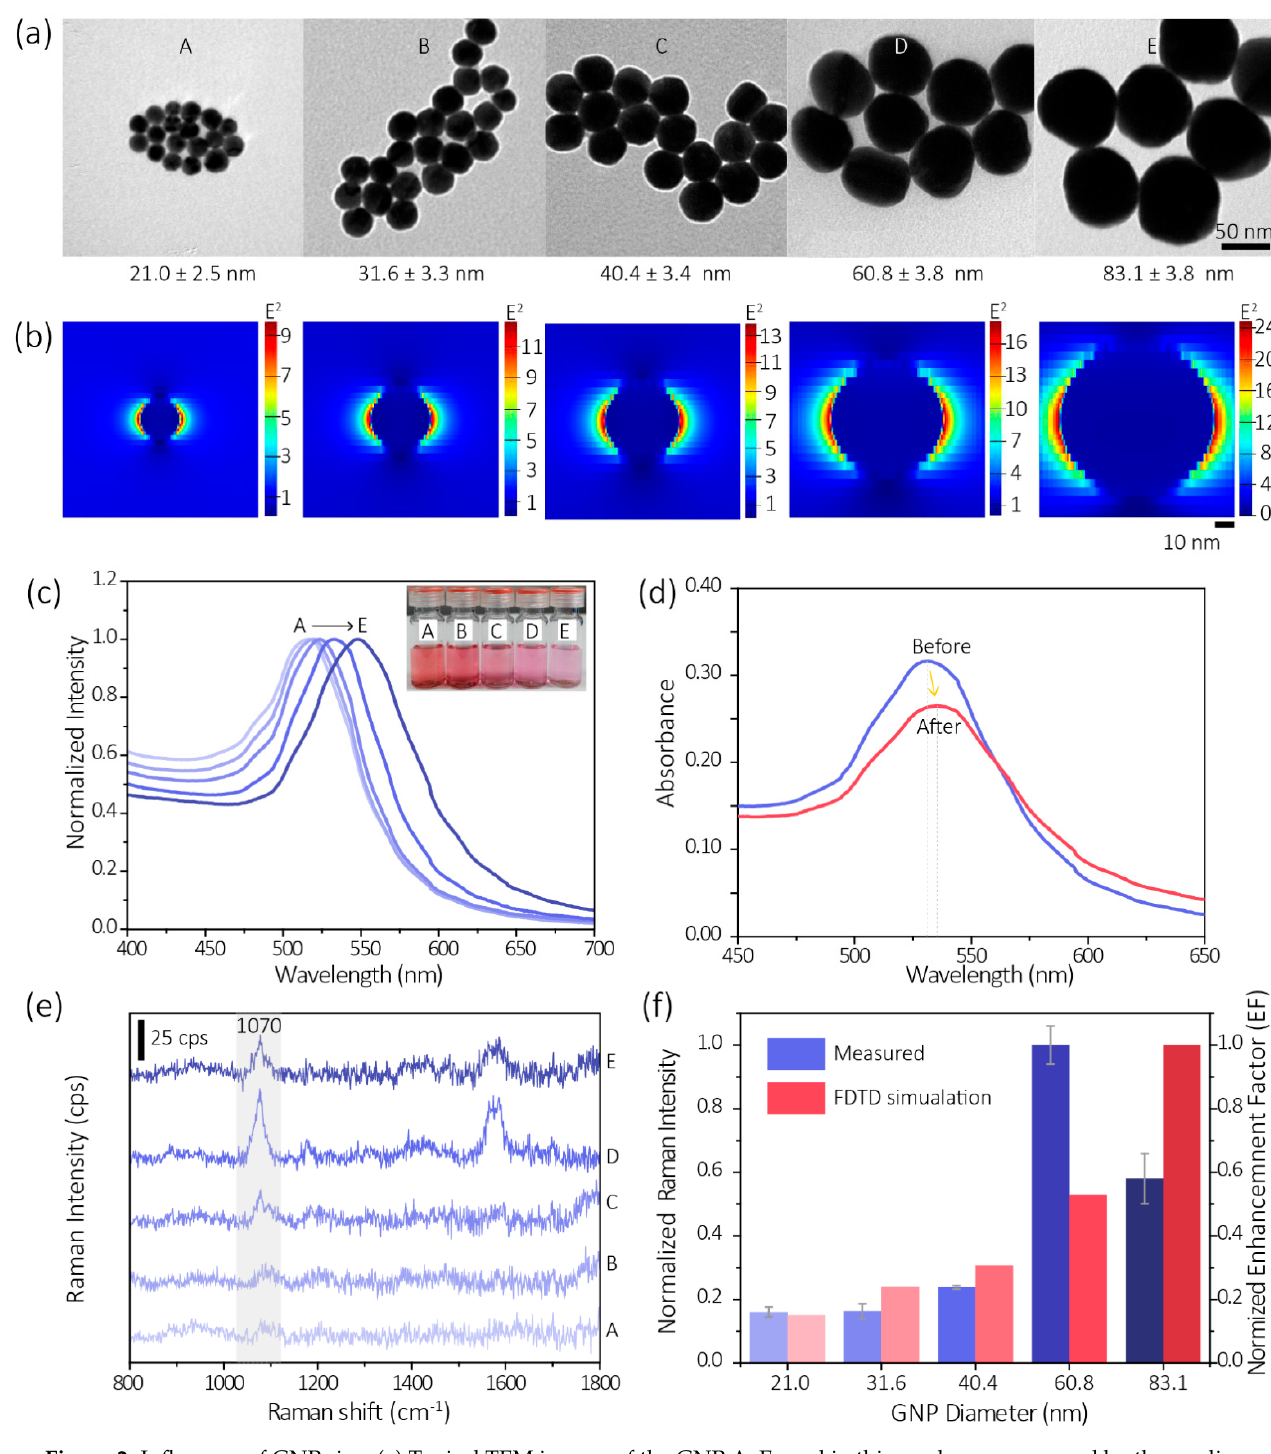
Figure 2. Influences of GNP size. ( a ) Typical TEM images of the GNP A-E used in this work were prepared by the seeding growth method. ( b ) FDTD simulations of the enhancement of field amplitude of the corresponding GNPs. In general, as the particle size increases, the amplitude increase. ( c ) LSPR absorption spectra of the obtained GNPs. The insert figure shows the photo of the obtained GNPs’ suspensions (GNP A-E). ( d ) Variation of LSPR absorption spectra before and after modification PATP. ( e ) SERS spectra of the obtained GNP-PATP probe with different particle sizes. ( f ) Comparison of the SERS intensities and situated SERS enhancement factor of different GNPs.